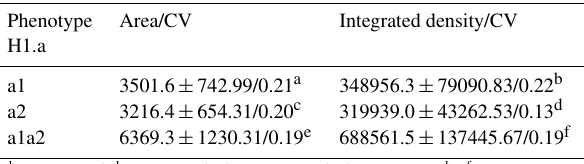
Table 1. Quantification of histone H1.a phenotypes. An area and the integrated density (mean ± standard deviation) of histone H1.a protein bands resolved with AU-PAGE was measured to determine the abundance of histone H1.a phenotypes. The measurements were conducted for 10 ( n = 10) histone H1.a protein bands of a given phenotype. The level of histone H1.a phenotypes relative variability was determined according to the values of CV.